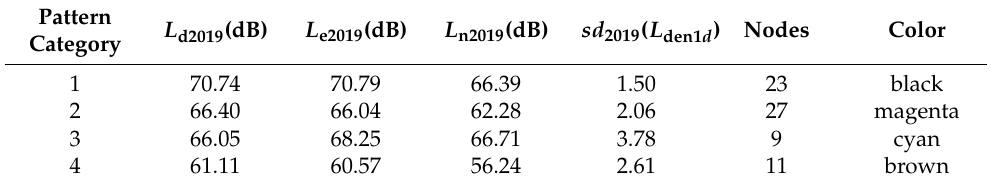
Table 1. Environmental acoustic pattern classification of BCN WASN (adapted from Pita, Navarro, and Rodriguez